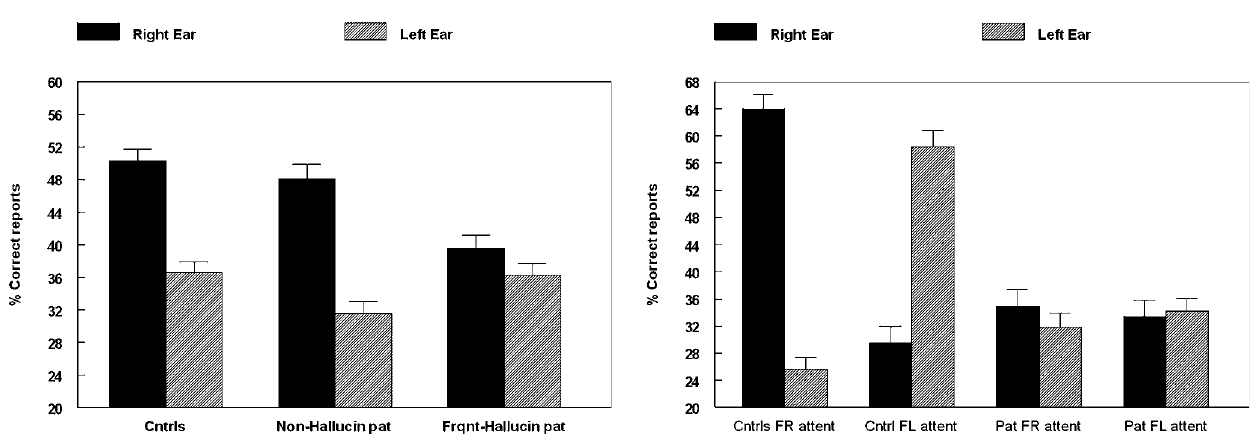
Figure 4. Percent correct reports on the CV-syllables DL paradigm split for right and left ear stimulus presentations, and healthy controls, non- hallucinating and frequently hallucinating patients.